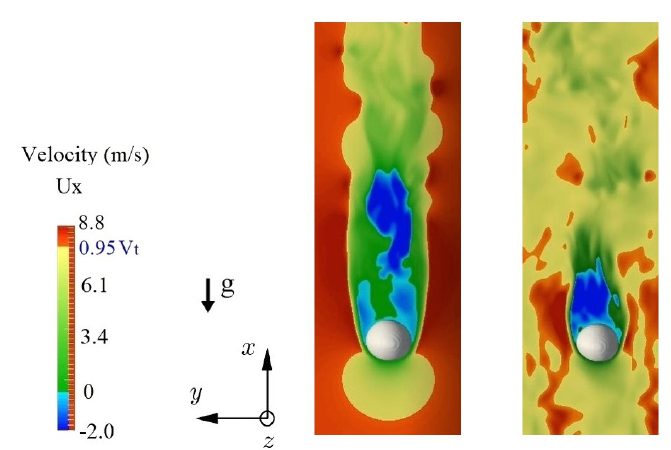
Figure 8. Comparison of the instantaneous (stream-wise) velocity field of a 3 mm water drop falling in still air ( left ) and that falling in turbulent air flow ( right ).